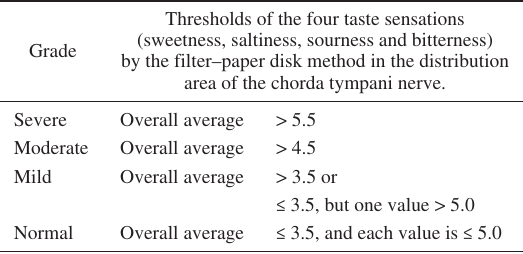
Table 1. Evaluation criteria for objective severity of taste disorders by filter–paper disk method (based on the criteria of Hamada et al. 1 ) Thresholds of the four taste sensations (sweetness, saltiness, sourness and bitterness) Grade by the filter–paper disk method in the distribution area of the chorda tympani nerve.